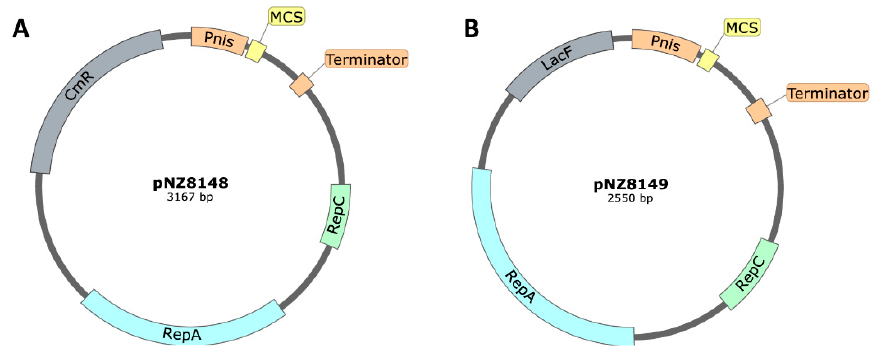
Figure 5. Map of ( A ) pNZ8148 [98] and ( B ) pNZ8149 [99]. The plasmids generally contain the replication origin genes ( repC and repA ), a selection marker (chloramphenicol resistance gene, cm R , or a food-grade marker, lacF ) and the gene of interest under the control of an inducible prokaryotic promoter (P nisA ). Table 3. Plasmids with a pSH71 origin of replication used as antigen-expressing vectors in L. lactis host, for mucosal vaccination purposes against several diseases.